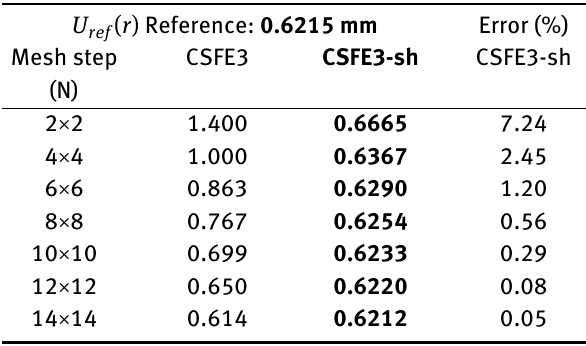
Table 5: Rate of transverse